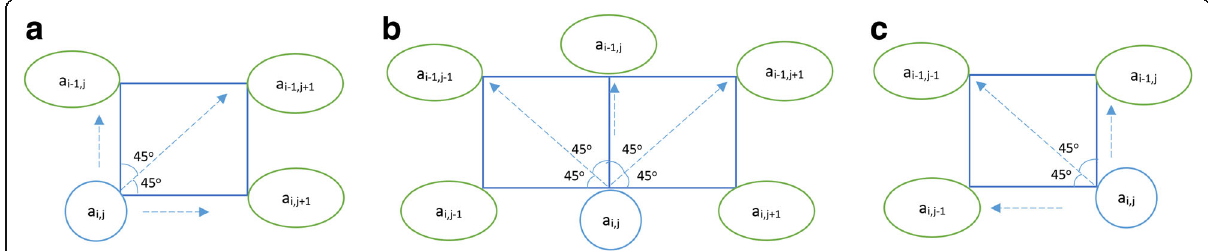
Fig. 13 RSS energy-enhanced depth-first algorithm development ( a , b , c ). The algorithms of Fig. 12 are illustrated separately from left, bottom and right respectively. a Erob from left enters routing decision (left). b Erob from bottom enters routing decision (middle). c Erob from right enters routing decision